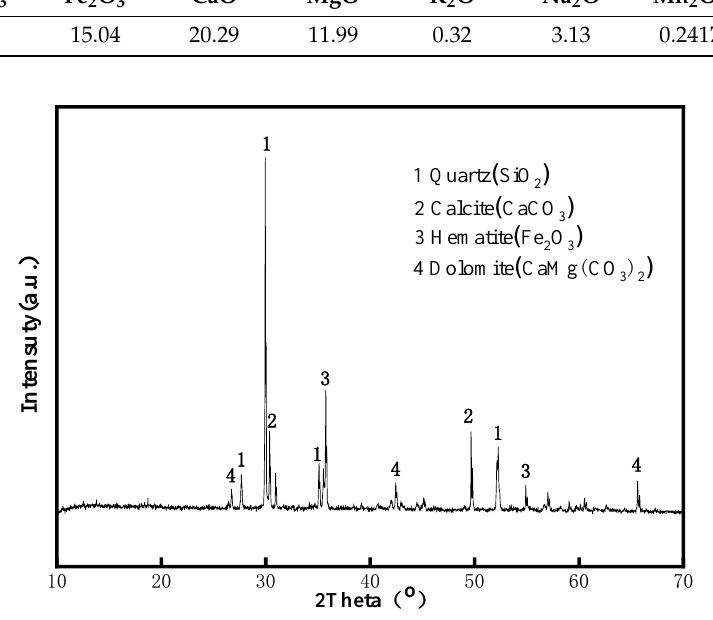
Figure 3. The ancestry of the iron tailings.